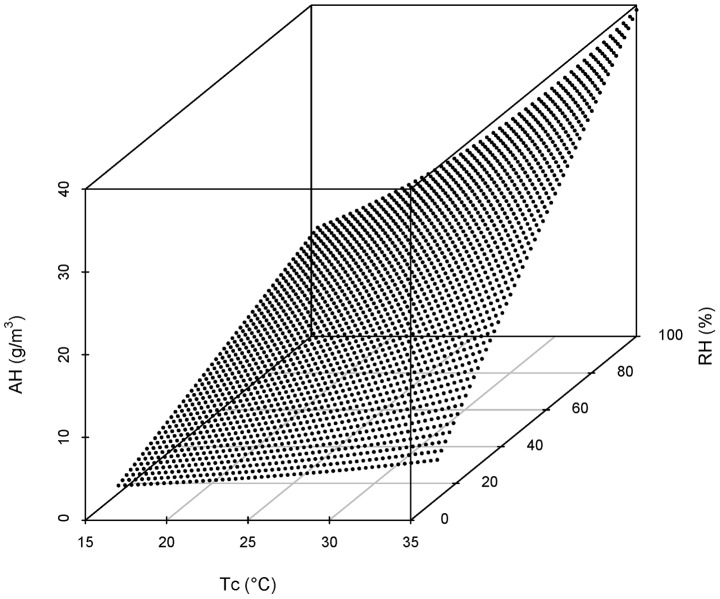
Scatter plot of AH v.s. Tc and RH ((Eq. 1)).